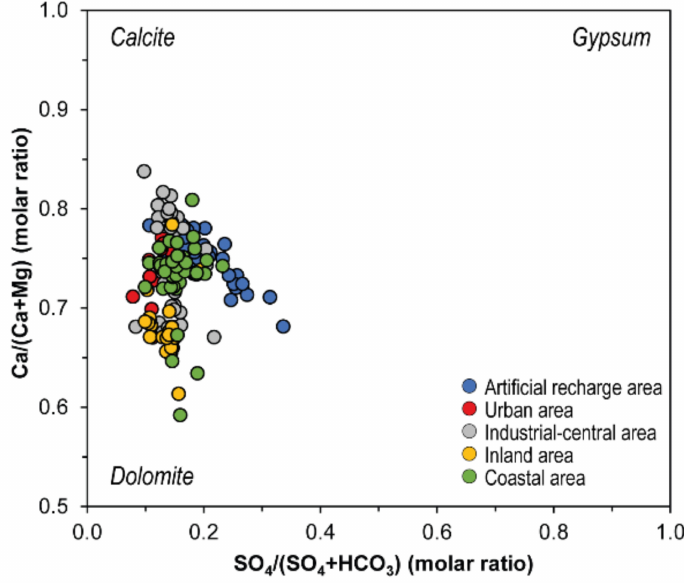
Figure 6. Ca/(Mg+Ca) vs. SO 4 /(SO 4 − HCO 3 ) diagram (after Frondini